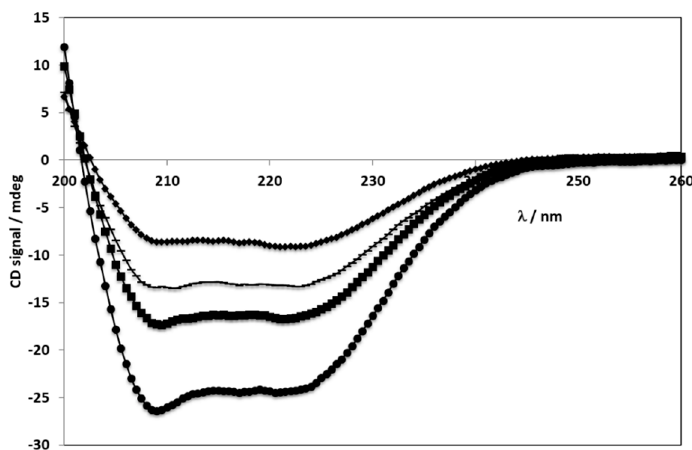
Figure 2. CD spectra measured in the far UV range for all samples: ● - BSA 0.2 mg/mL; ♦ - BSA NPs